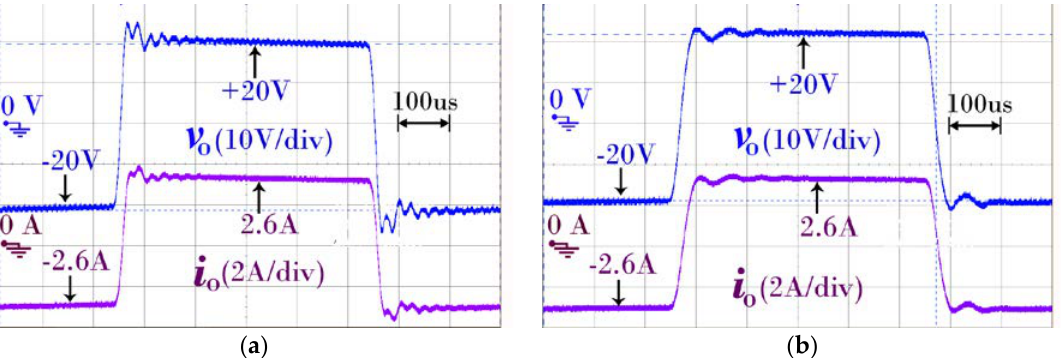
Figure 11. Experimental results transient response of: ( a ) open-loop GaN class-D amplifier; ( b ) GaN class-D amplifier with FFDISMC.